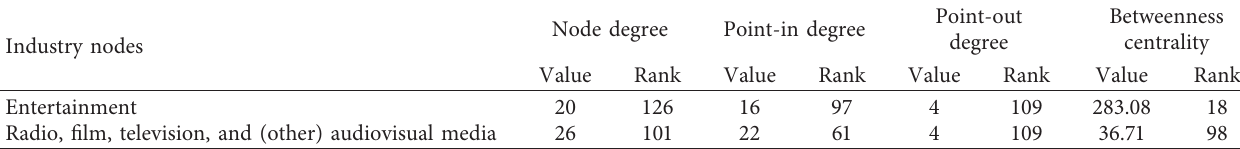
Table 6: Statistical table of node characteristics of the entertainment